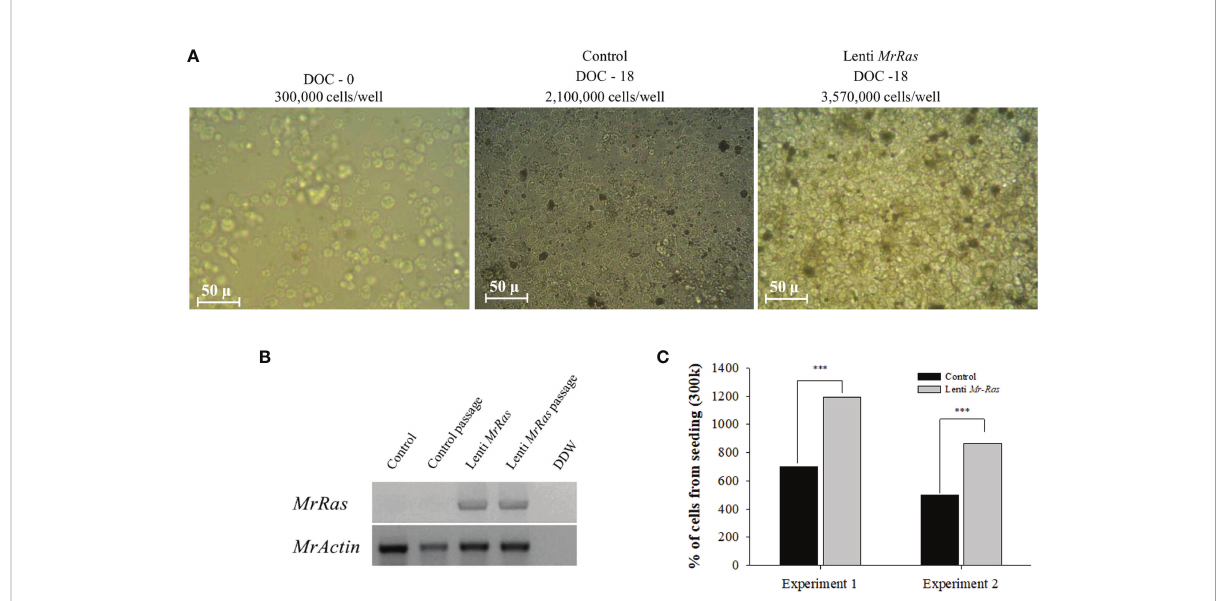
FIGURE 8 Proliferation in M. rosenbergii embryonic cell cultures and detection of the MrRas sequence in the genome of the transduced cells. (A) Representative light microscope images of cells seeded at a density of 300K cells/well (A, left); after 18 days in culture, control non-transduced cells (A, middle); and mutated lenti MrRas transduced cells (A, right). DOC = days of culture, scale bar = 50 µm. (B) Agarose gel of PCR products on gDNA template isolated from culture after 18 days in culture to con fi rm the presence of the genes in M. rosenbergii primary embryonic cells, including cells after one passage. (C) Percent of cells from seeding density in mutated lenti- MrRas transduced cells compared to control non- transduced cells. Statistical analysis was done using Chi-square contingency analysis performed on the proliferation rate data. Analysis performed using R software. *** refers to the statistical signi fi cant p